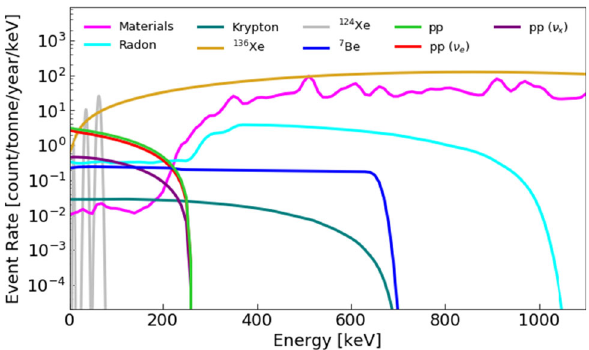
Fig. 8 The electronic recoil spectra of two solar neutrino components and five backgrounds up to 1.1 MeV. The pp neutrino component is divided by lepton flavor. The solar components follow from the high-Z SSMmodel.Thematerialsand 136 Xeeventsin[1.1,3]MeV(notshown) arealsousedinthestatisticalanalysis.Thematerialscomponentisbased on a selection of events in a 30 t fiducial